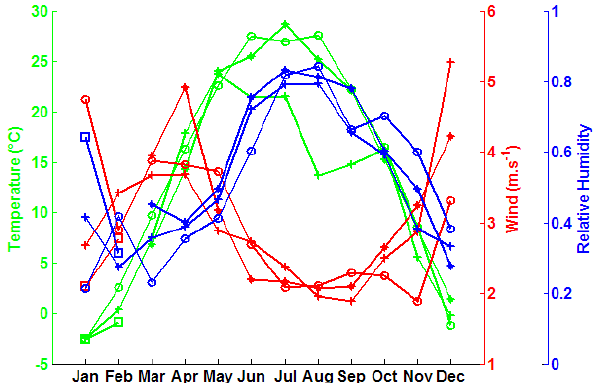
Figure 12. Seasonal cycles (monthly means) of temperature, hu- midity, and wind speed in 2010 (marker: star), 2011 (plus), 2012 (circle), and 2013